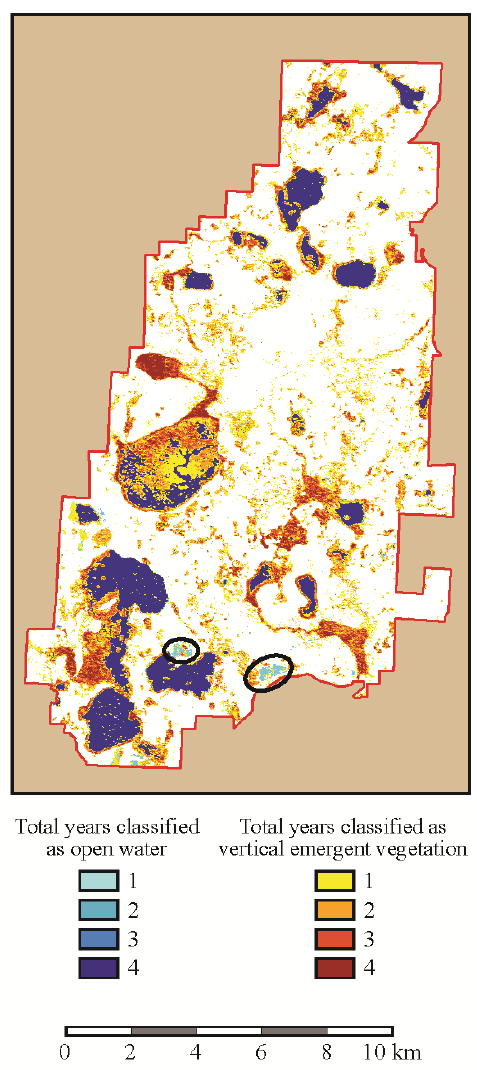
Figure 8. Map showing the number of years for which a pixel was classified as vertical emergent vegetation or